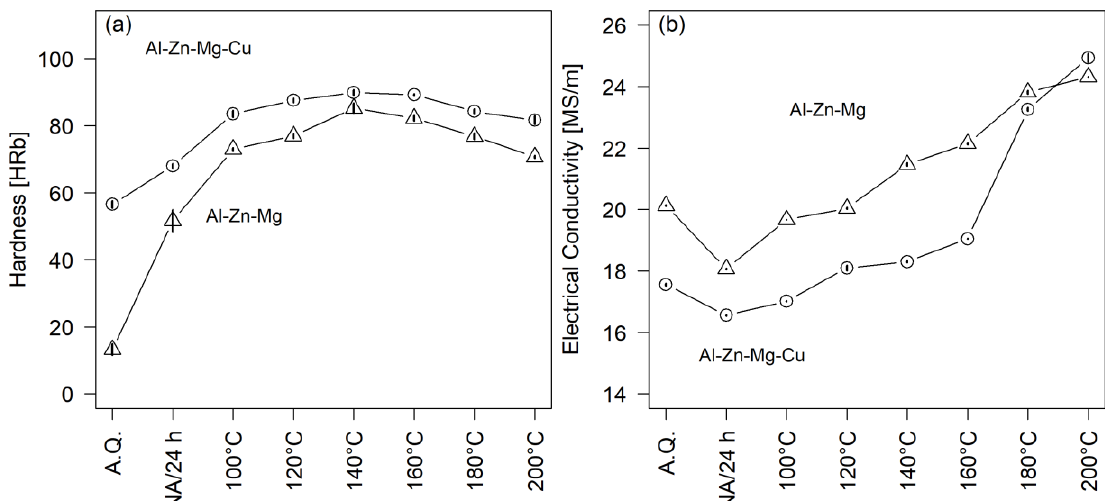
Figure 4. ( a ) Rockwell B hardness (HRb) for Al-Zn-Mg (triangles) and Al-Zn-Mg-Cu (circles) alloys for multiple conditions: as-quenched (A.Q.); natural aged for 24 h (NA); and isothermal annealing treatments from 100 to200 ◦ C (each treatment was 3 h). ( b ) Electrical conductivity (MS / m) for Al-Zn-Mg (triangles) and Al-Zn-Mg-Cu (circles) alloys for multiple conditions: as-quenched; 24 h of natural age (NA); 3 h isothermal annealing treatments from 100 to 200 ◦ C. Error bars equal the 95% confidence interval of the